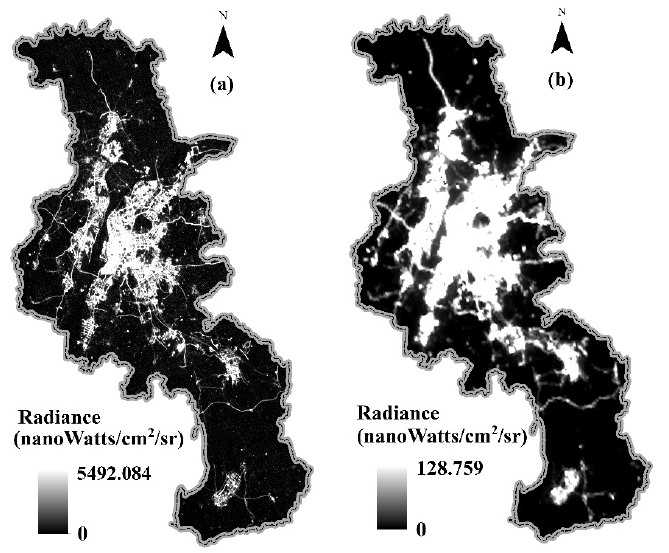
Figure 1. City structure of Nanjing City represented by radiometric corrected nighttime light (NTL) images of ( a ) Luojia 1-01 and ( b ) Visible Infrared Imaging Radiometer Suite (VIIRS).